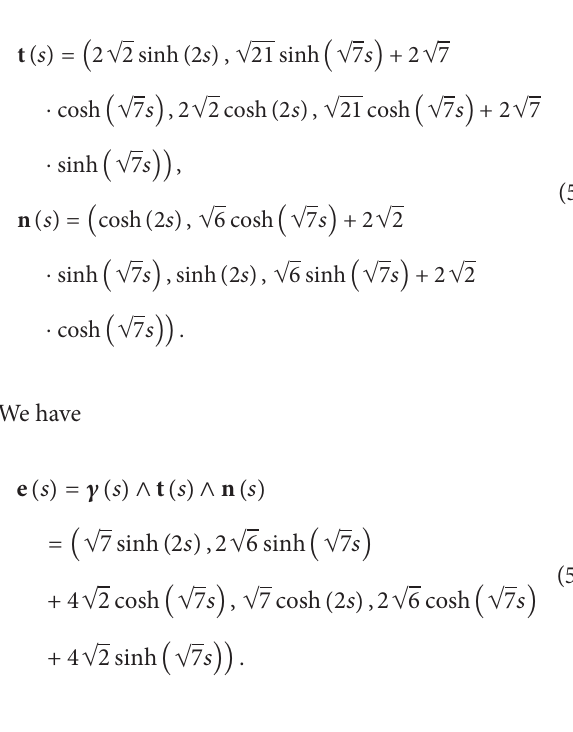
Figure 4: Projection of 𝐿 − 𝜃